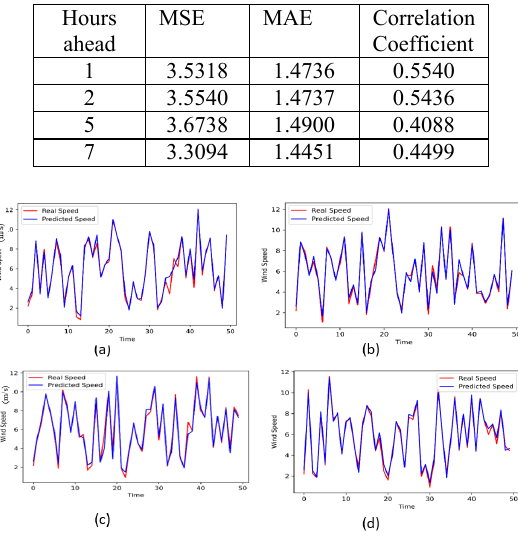
Table 5. Errors and correlation coefficients in Case 5 for all scenarios.